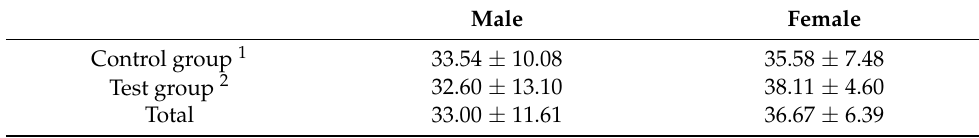
Table 1. Comparison of test and control groups by average age of male and